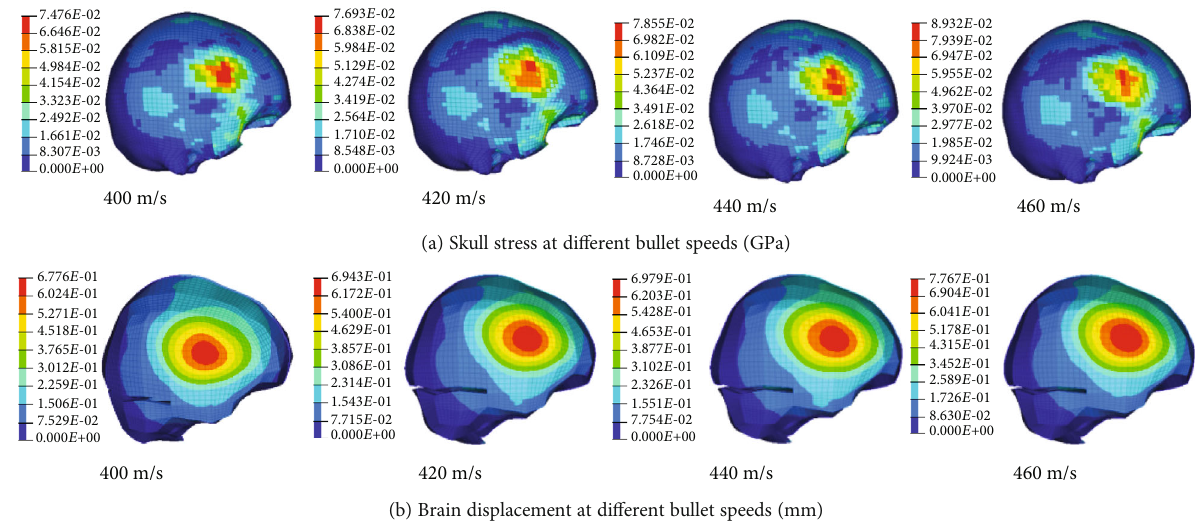
Figure 9: Head response at di ff erent bullet speeds.